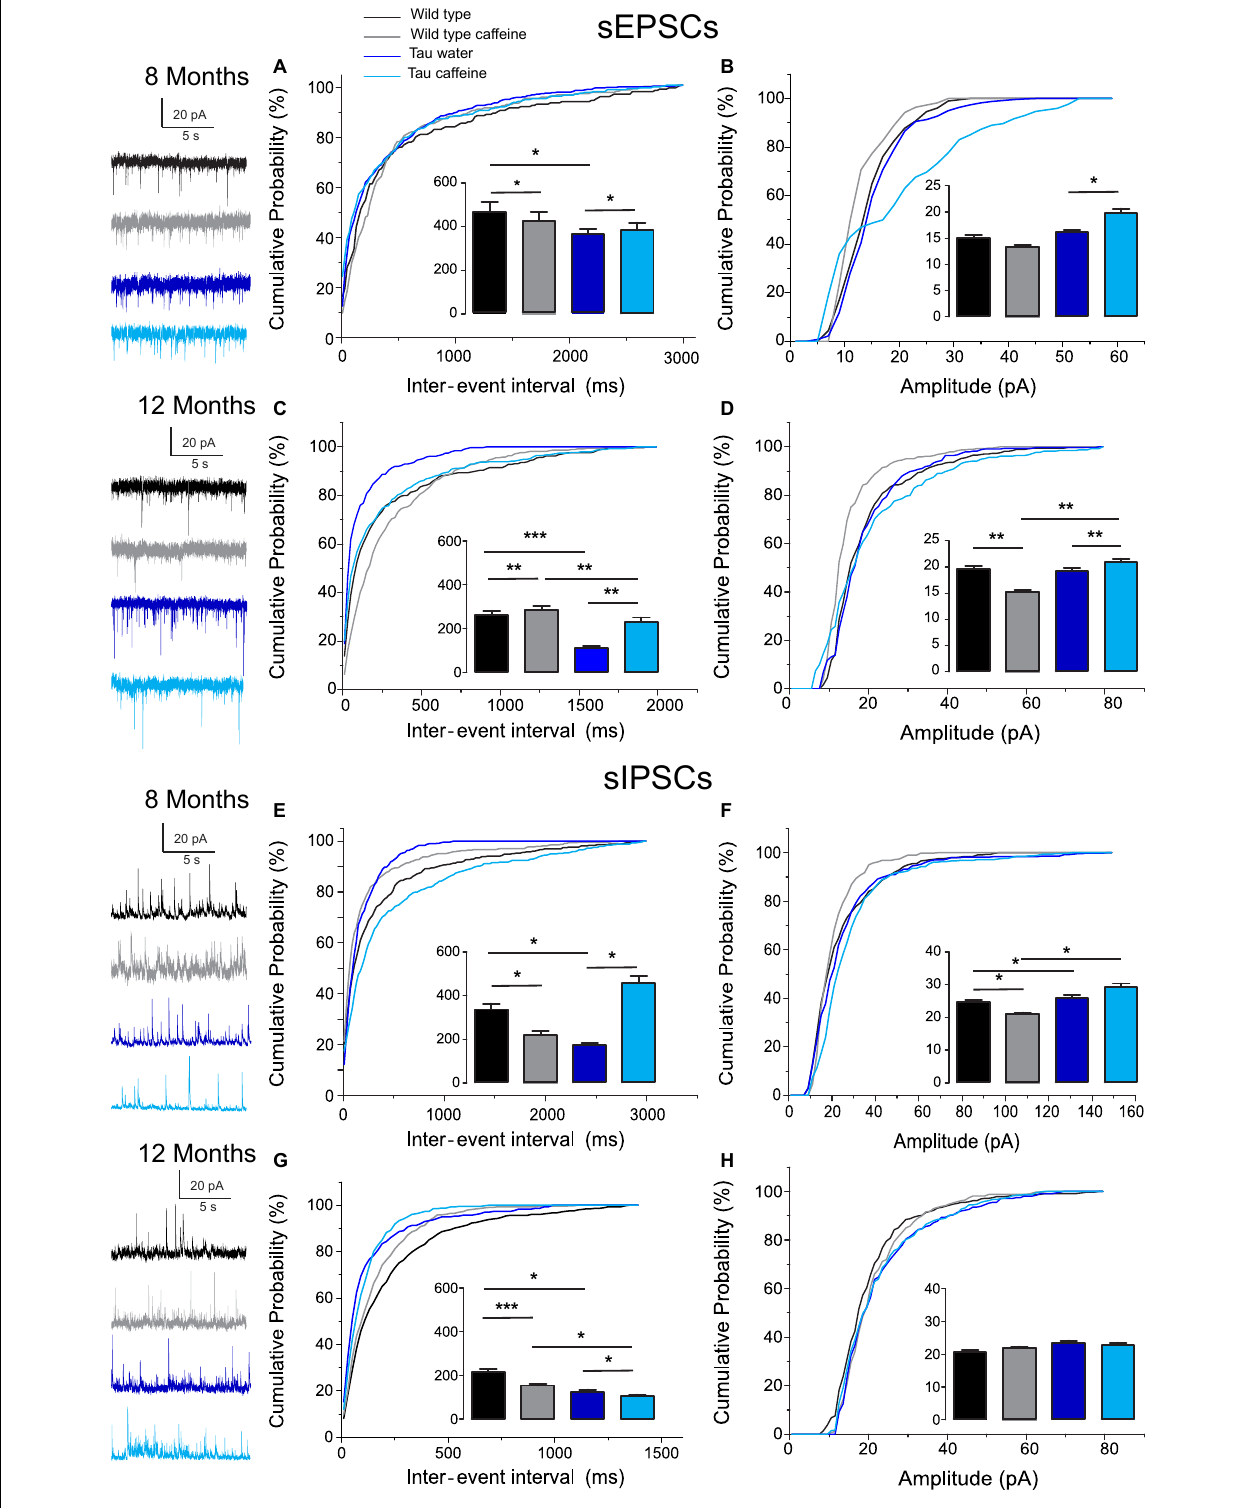
FIGURE 1 | Investigation of chronic caffeine exposure on spontaneous glutamatergic and GABAergic in vitro activities in 8 and 12 month-old Wild type and Tau mice. Representative traces of sEPSCs and sIPSCs recorded in CA1 hippocampal pyramidal cells of Wild type water (black), Wild type caffeine-treated (gray), Tau water (blue), and Tau caffeine-treated (light blue) mice are depicted on the left of the cumulative probability histograms [8 month-old sEPSCs: (A,B) ; 12 month-old